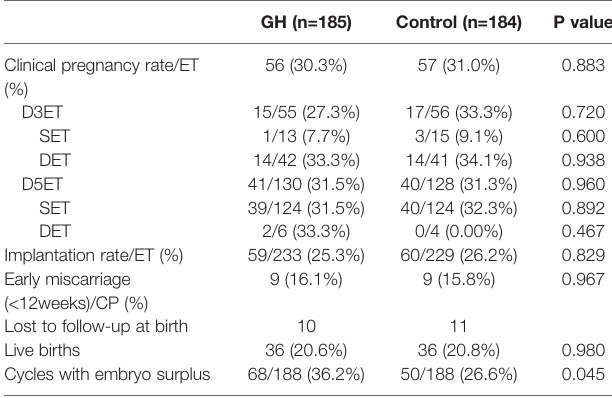
TABLE 4 | Clinical outcomes of frozen-thawed